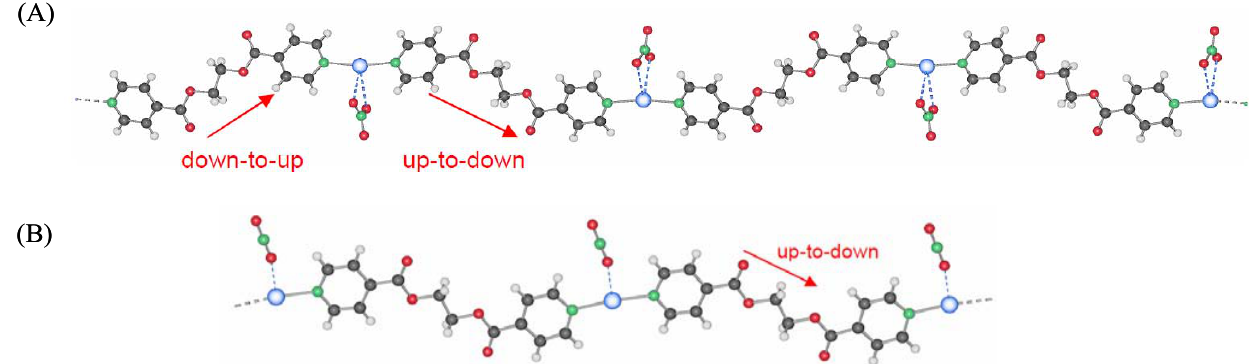
Figure 1. Structure of [Ag(L)NO